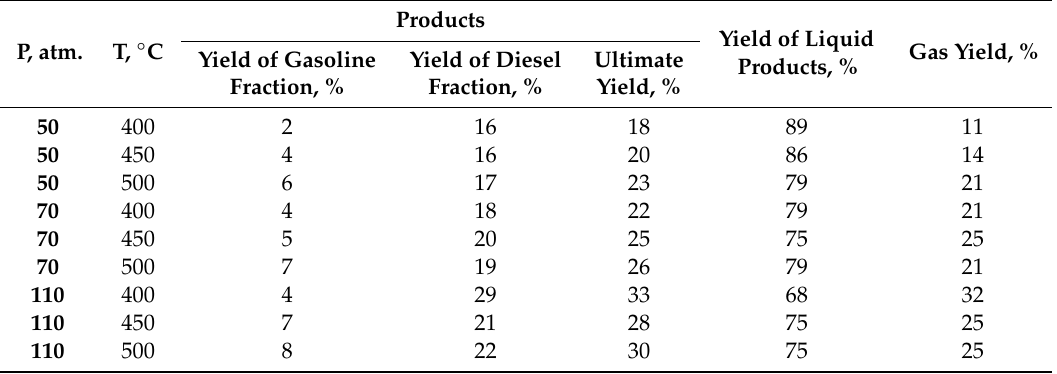
Table 2. Influence of the severity of process conditions on the yield of light fractions in oil sludge hydrocracking on the SGK-5 catalyst. Products P, atm. T, ◦ C